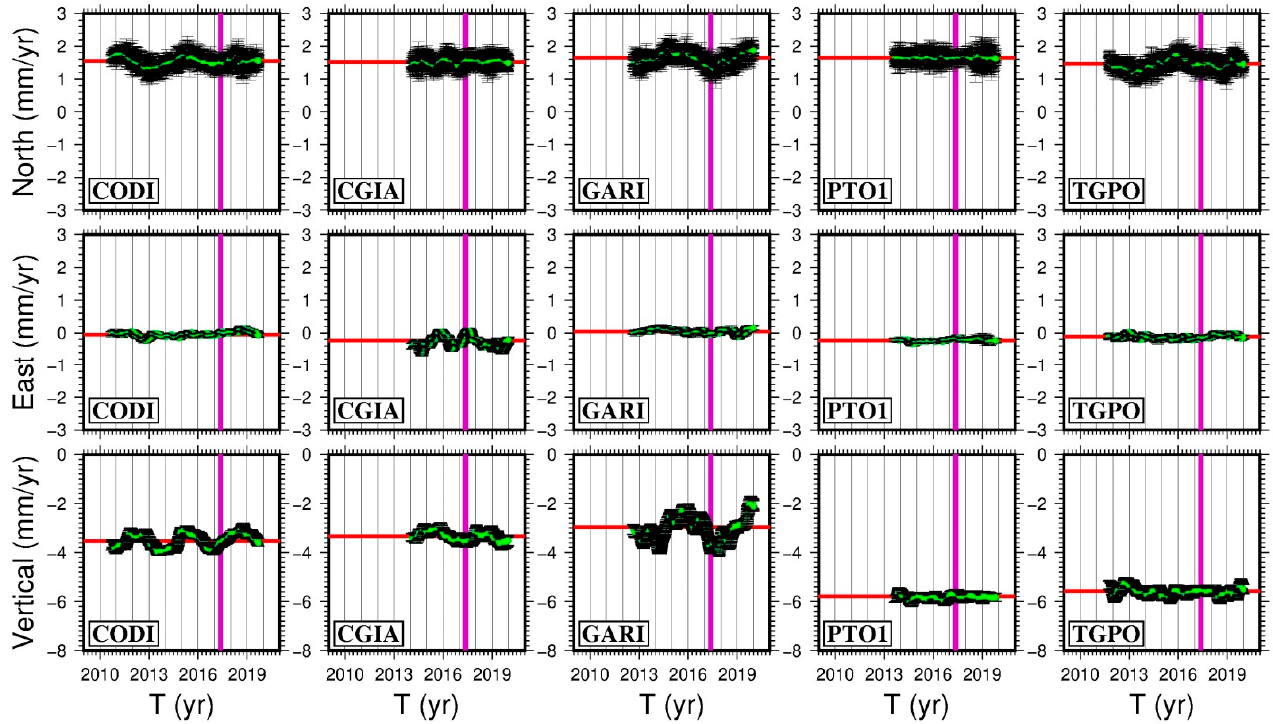
Figure 5. IV time-series of the CGNSS sites located in the PRD area obtained using the VMWA with a window of 1128 days (the time span between the first and last InSAR images processed). The windows containing less than 500 days were rejected. We have analyzed the time series using the model described in equation 1 without discontinuities and significant seasonal signals and estimated by a weighted least square method. The black bars represent the uncertainties associated with the IV obtained with the weighted least square method used to compute the rates. The horizontal red lines represent the velocities obtained with the entire time series and are reported in Table 1. The purple vertical line represents the data related to the last day of the InSAR observations (17 May 2017). The IV associated with this data are the values corresponding to the time span between the InSAR images.